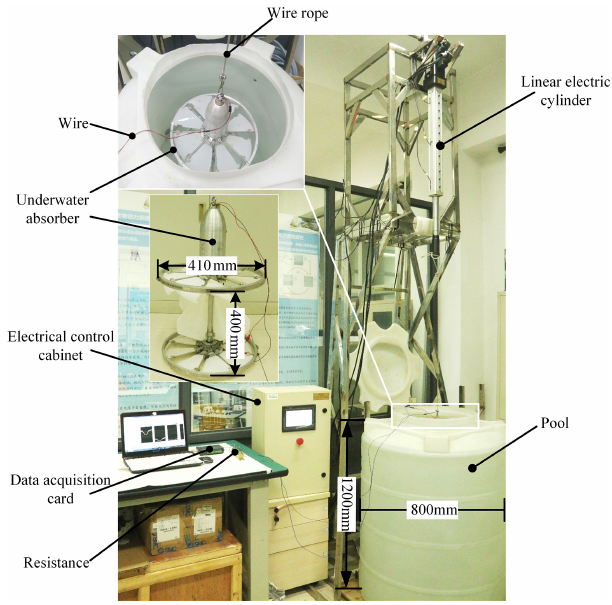
Figure 7. An energy efficiency test platform for a multi-body heave wave energy